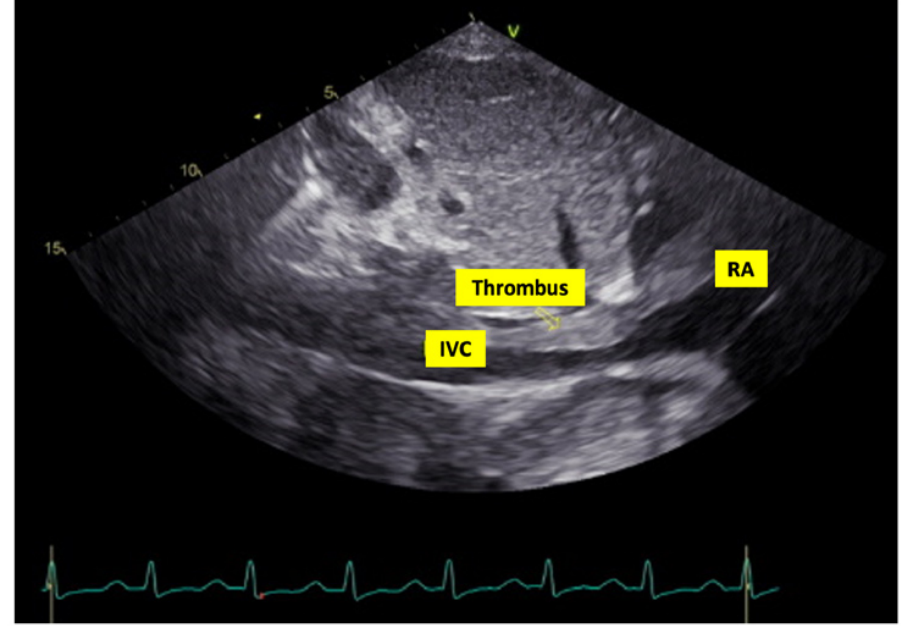
Figure 4. Transthoracic echocardiogram (TTE) showing thrombus in the inferior vena cava. RA = right atrium; IVC = inferior vena cava.